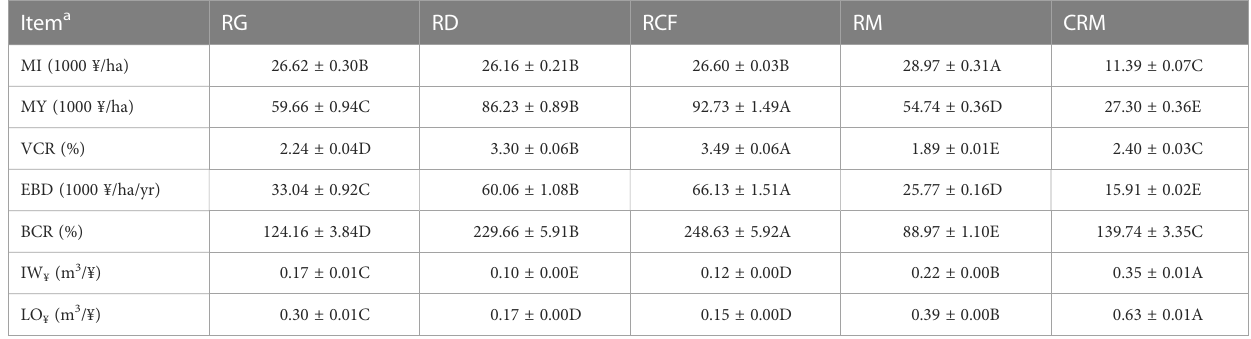
TABLE 3 Comparison of economic indices of the fi ve rice production modes.